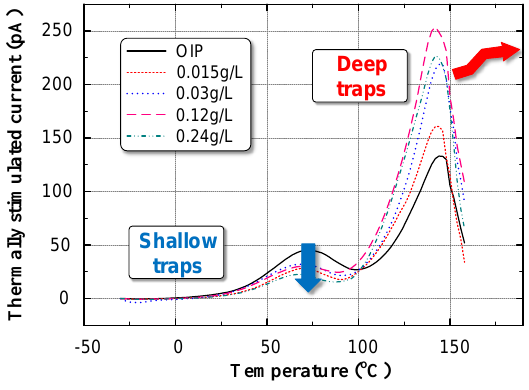
Figure 11. Thermally stimulated current of OIP and NOIP.